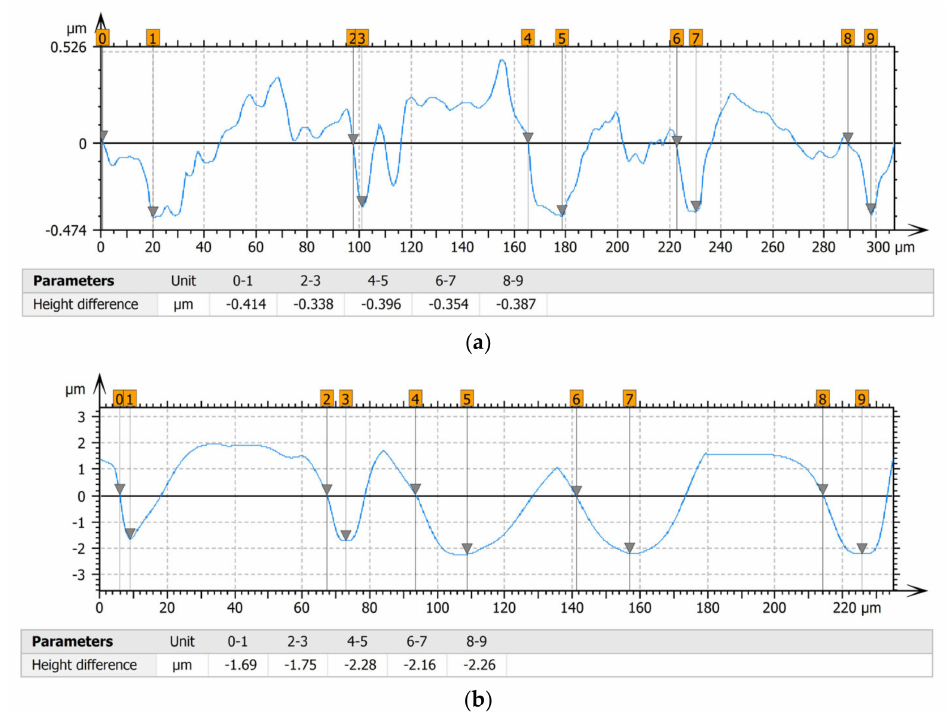
Figure 3. Valley characteristics: ( a ) Surface A, ( b ) Surface B.